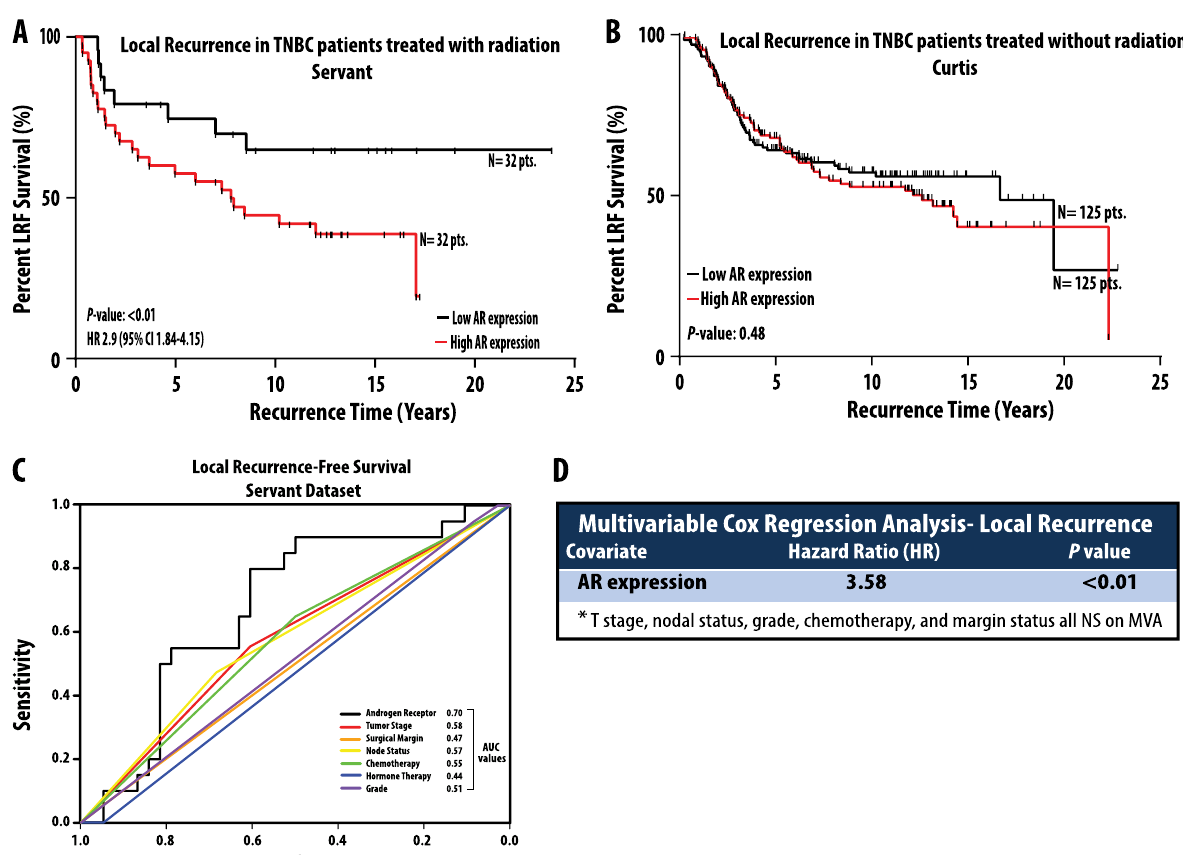
Fig. 2 AR expression is predictive of response to radiation. Kaplan – Meier local recurrence-free survival analysis in the Servant data set demonstrates that patients with TNBC whose tumors have higher than median expression of AR ( red line ) have signi fi cantly higher rates of local recurrence after radiation and an overall poorer prognosis than patients with lower than median expression ( black line ) of AR ( a ). In patients with TNBC who did not receive radiation treatment, there was no difference in local recurrence depending on higher ( red line ) or lower ( black line ) than median expression of AR ( b ). Receiver operator curve analysis in the Servant data set demonstrates that AR expression level with the highest AUC value (0.69) when compared against other clinicopathologic parameters ( c ). In multivariable Cox regression analysis in the Servant data set, only AR expression remained signi fi cantly associated with worse local recurrence-free ( LRF ) survival ( d ). Hazards ratios, 95% con fi dence intervals, and p -values were calculated for all analyses and are